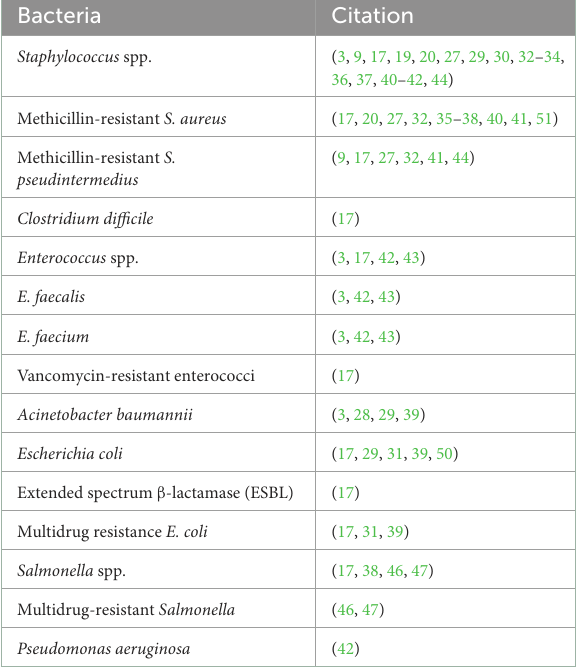
TABLE 3 Organism reported in hospital-acquired and/or zoonotic infections in veterinary facilities between 2000 and 2020. Bacteria Citation Staphylococcus